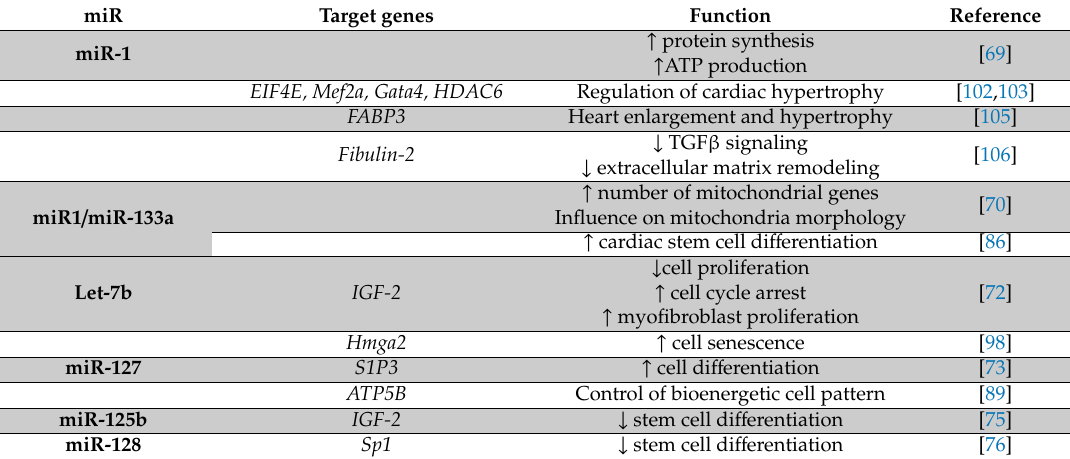
Table 1. Summary of mitomiRs function and its known